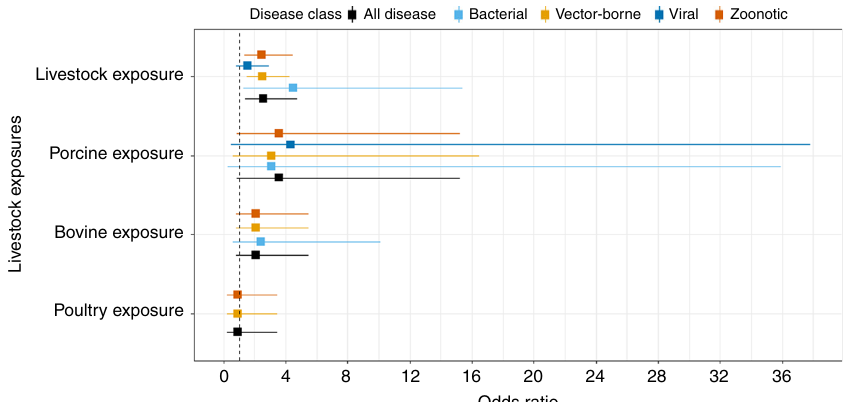
Fig. 6 Livestock exposure-based subgroup analysis. Livestock farming is de fi ned as a category where a person indicates they are exposed to livestock generally regardless of the speci fi c type of livestock (e.g., chickens). Porcine, Bovine or Poultry exposure is de fi ned as a person being exposed to each of these respective animal types. Square points show the pooled subgroup estimates and error bars are de fi ned as the 95% con fi dence